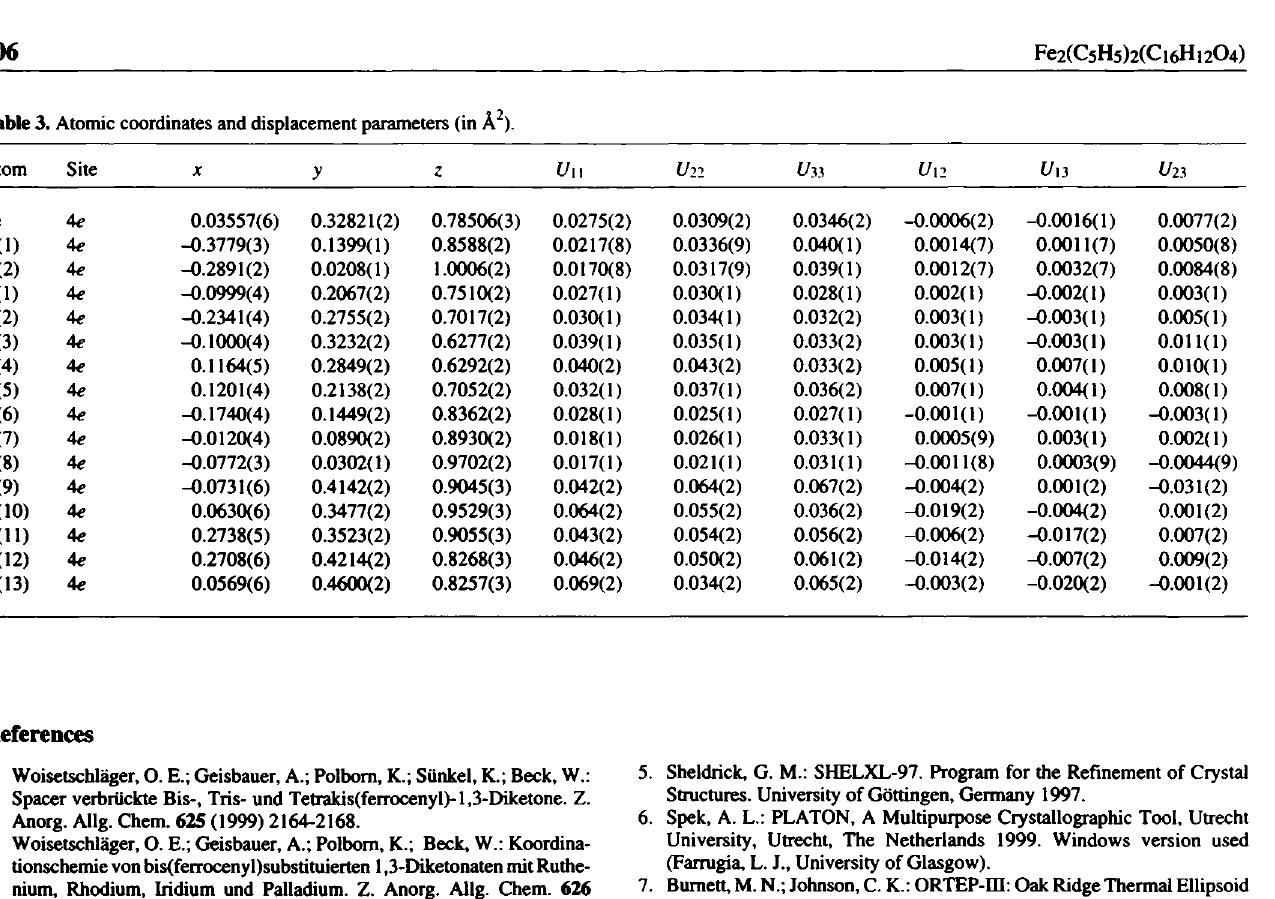
Table 3. Atomic coordinates and displacement parameters (in À 2